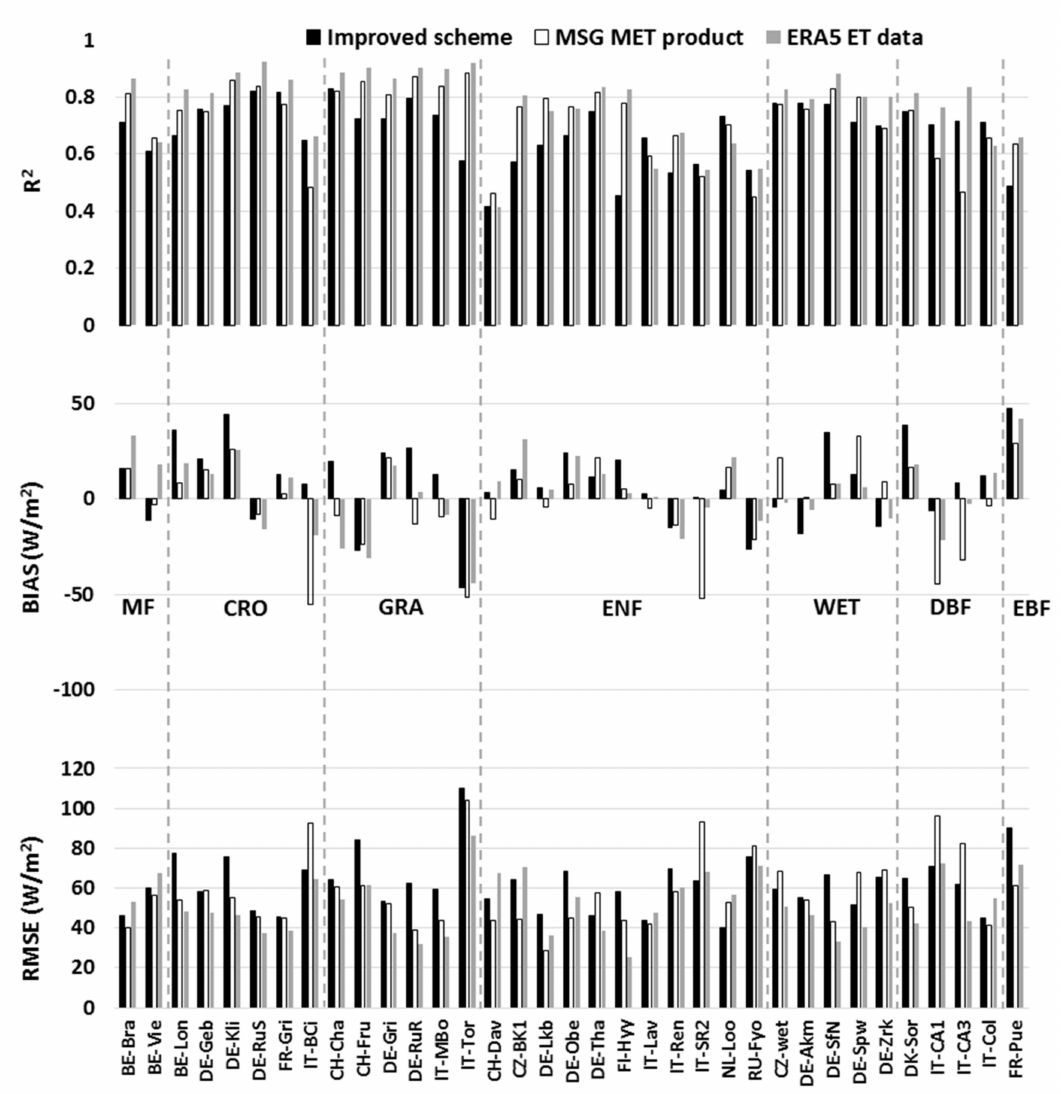
Figure 4. Statistical values of comparisons of instantaneous LE from improved scheme, MET product and ERA5 ET data with in situ measurements from FLUXNET2015 for each site (dashed lines separate sites with di ff erent land